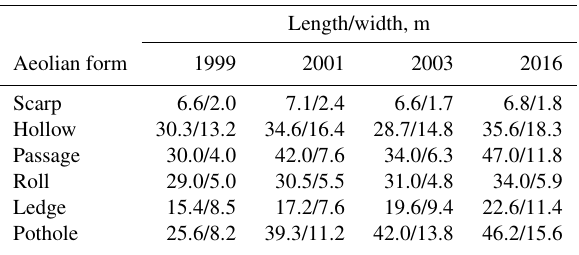
Table 3. Transformation of aeolian deflation relief forms in 1999–